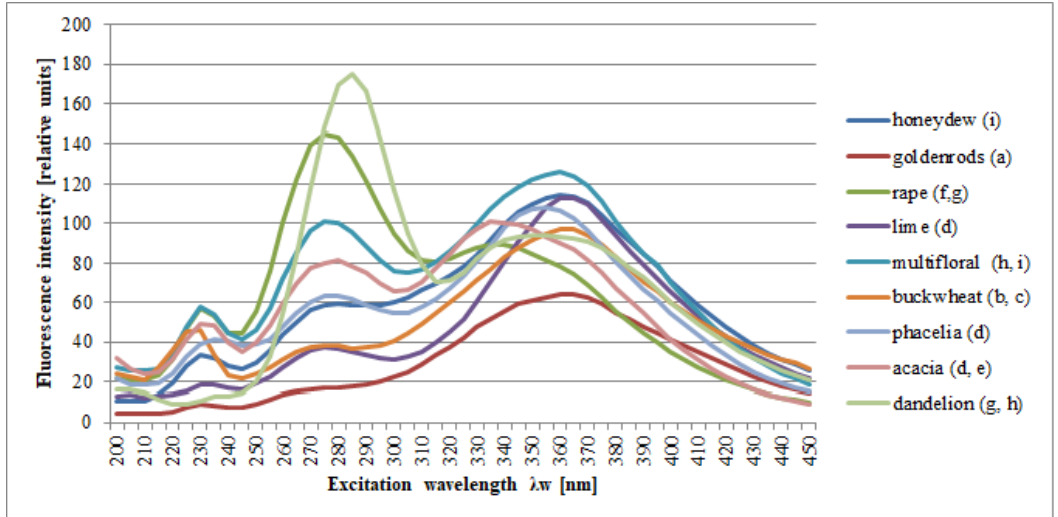
Figure 2. Normalized fluorescence emission spectra of di ff erent botanical origins of unfiltered honeys; the letters ( a – i ) indicate homogeneous groups, separated as a result of post-hoc analysis (Duncan’s test). Source: own